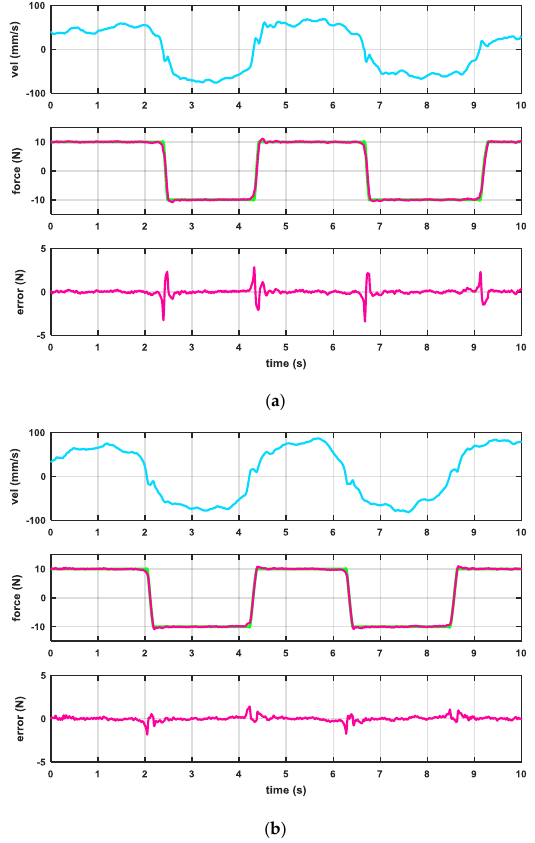
m  ): ( a ) D = 100 rad/s, ( b ) D = 1000 rad/s. Figure 13. The control response at the friction force ( m d = 1.8 kg): ( a ) D = 100 rad / s, ( b ) D = 1000 rad / m m